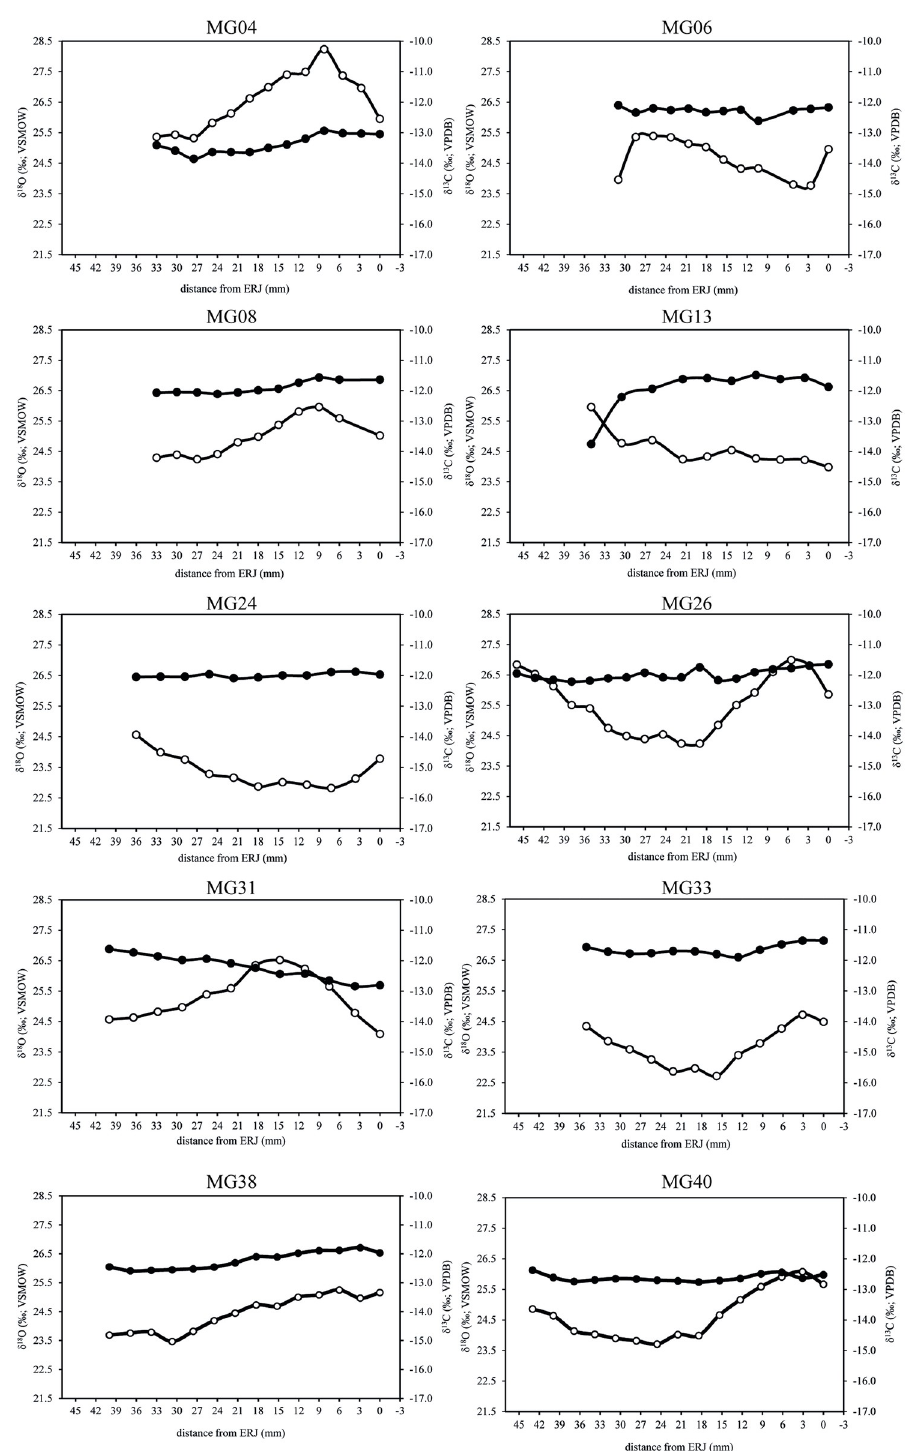
Fig 7. Results from the sequential analysis of oxygen ( δ 18 O, white circles) and carbon ( δ 13 C, black circles) isotope composition in sampled enamel bioapatite from 10 cattle lower third molars (M3).